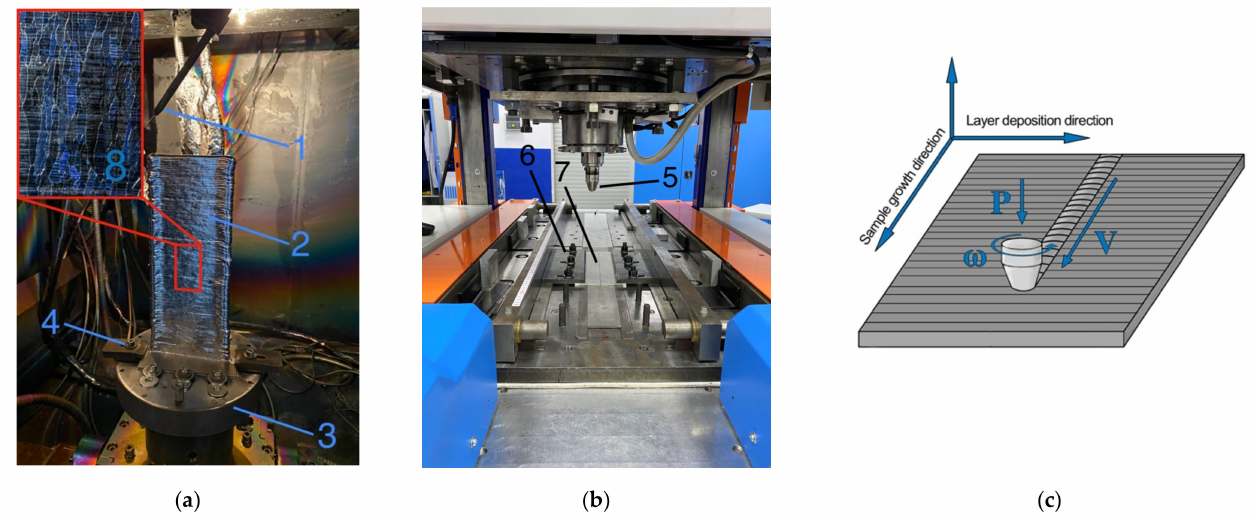
Figure 1. Vacuum chamber of the wire-feed electron beam additive manufacturing equipment with 3D-printed workpiece ( a ); the friction stir welding machine ( b ); and scheme of friction stir processing in the sample growth direction ( c ). 1—wire-feeder, 2—as-built workpiece, 3—working table, 4—substrate clip, 5—FSW-tool, 6—clamps, 7—FSP’ed workpiece, 8—surface of an additive as-built workpiece with columnar grains, V—tool movement speed, P—tool loading force, ω —tool rotation